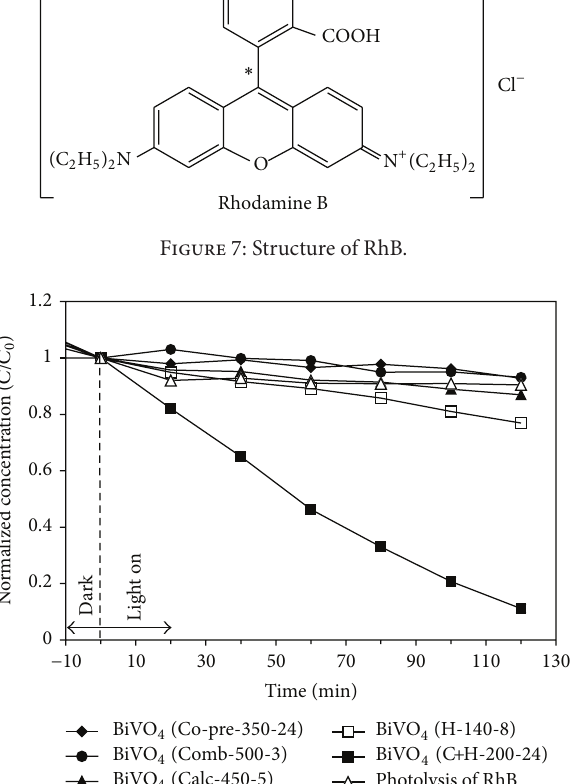
Figure 8: Photocatalytic degradation of RhB (5mg L −1 ) in the absence and presence of various BiVO 4 samples under visible-light irradiation for 2 h.